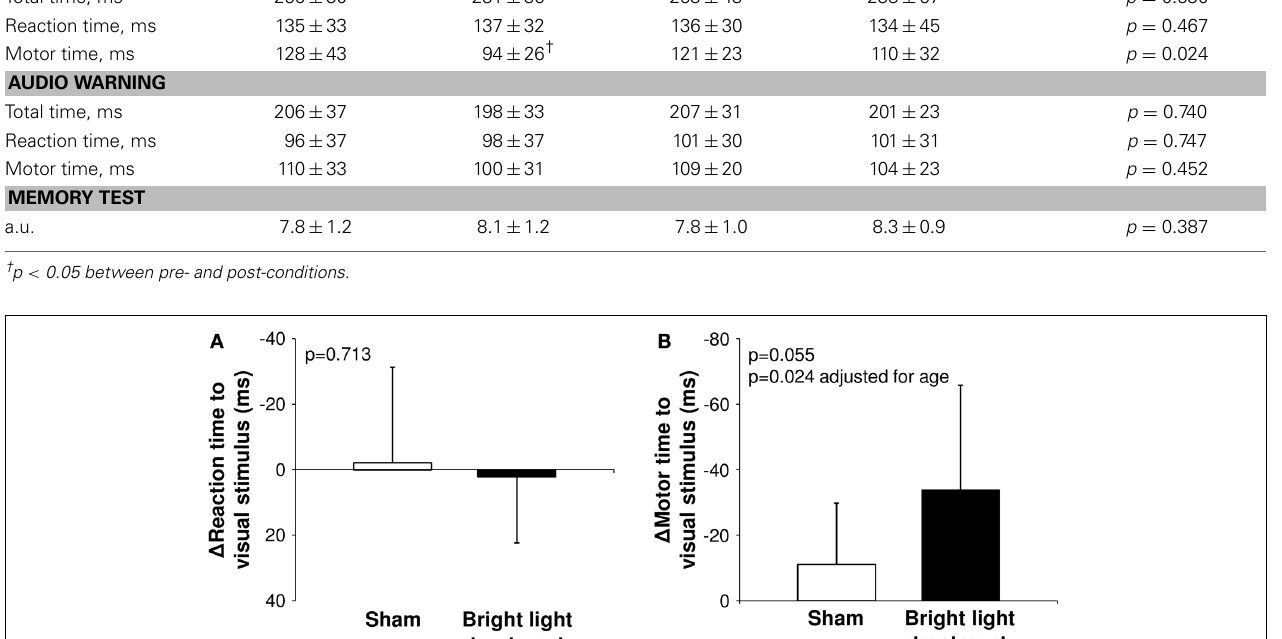
quantities in the cerebral cortex, hypothalamus, and cerebellum, which is known to modulate e.g., motor function and